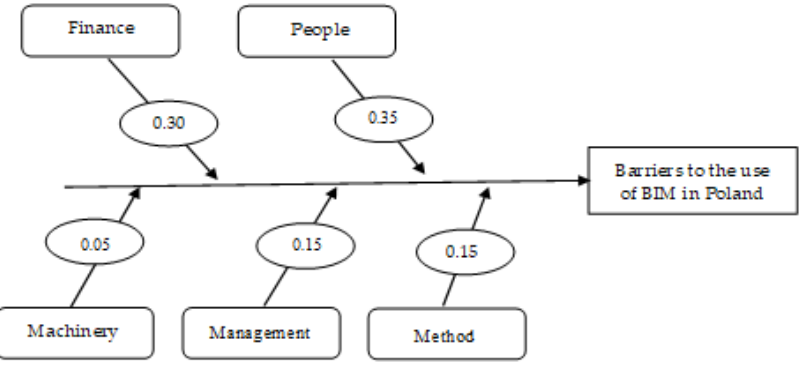
Figure 8. Ishikawa diagram—significance weights of the main categories of barriers to the use of BIM in Poland.